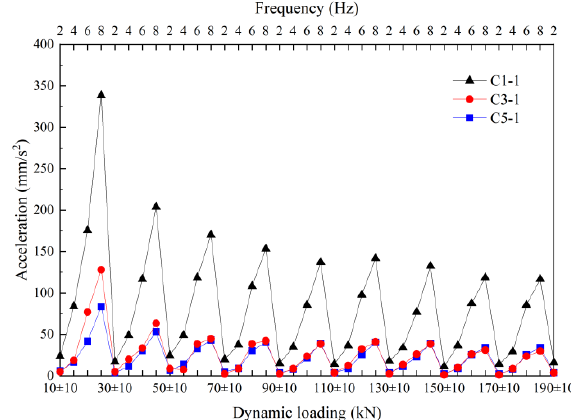
Figure 11. Variation in acceleration peak and frequency.